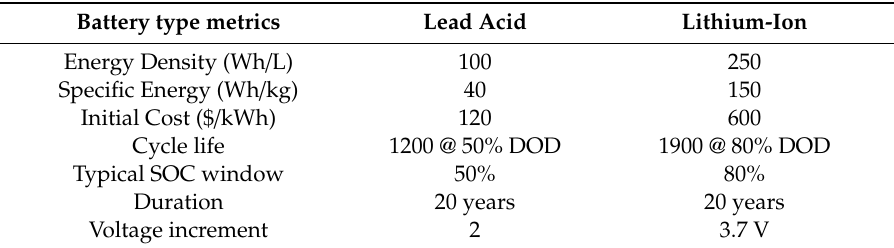
Table 2. Comparison table between